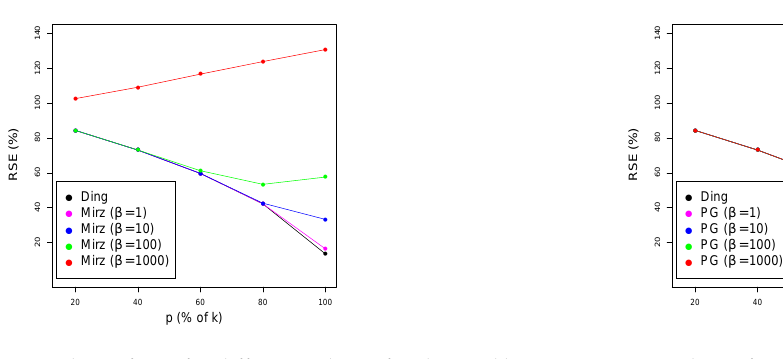
Values of RSE for different values of β obtained by Algorithms 1 and 2 in BION data with n = 1000 Figure 3. This figure contains six plots which illustrate the quality of Algorithms 1–3 regarding RSE on BION instances with n = 100,500,1000 and k = 0.2 n , 0.4 n , for β ∈ { 1,10,100,1000 } . We can observe that Algorithm 3 is more stable, less dependent to the choice of β and is computing better values of